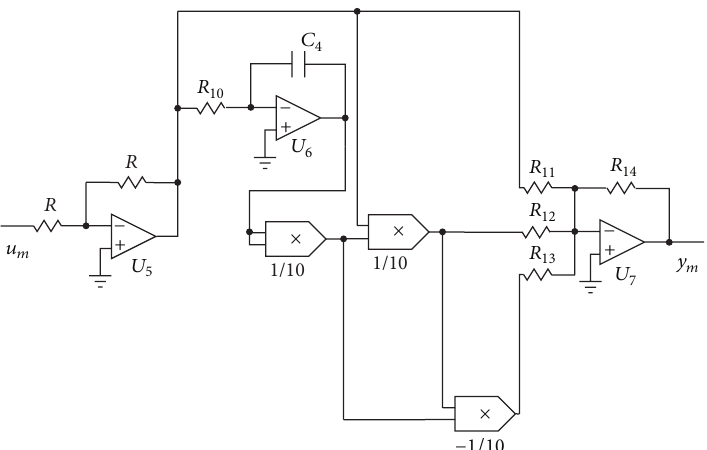
Figure 7: Circuitry realization which emulates the memristive device (2).